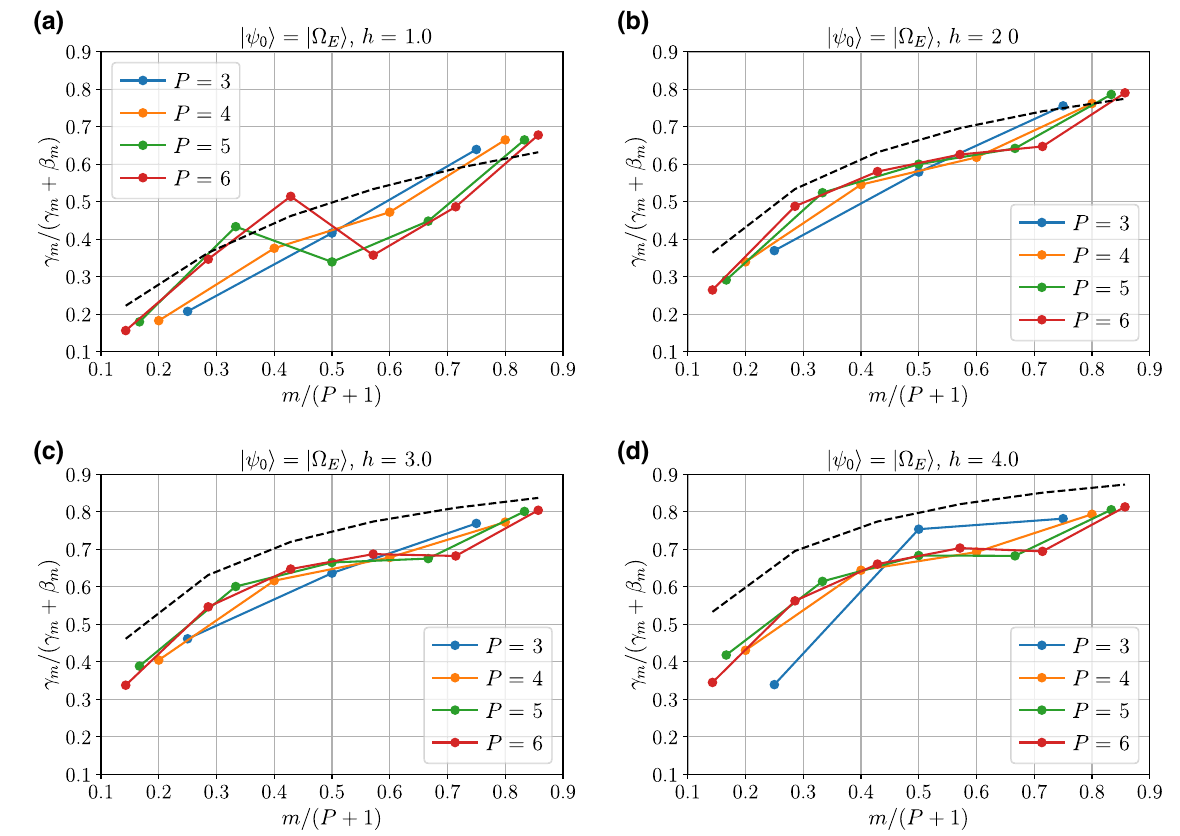
FIG. 15. Variational parameters associated with the best result out of ten local minimum searches, following the two-step optimiza- tion procedure. In each panel, the black dashed line corresponds, through Eq. (B5), to the linear annealing schedule defined by Eq. (15), with the corresponding value of h and P = 6 steps. The quantum circuit is initially prepared in the electric ground state | (cid:5) E (cid:3)